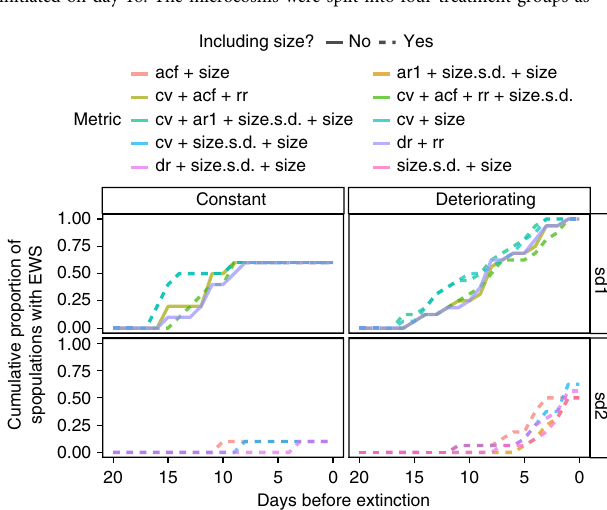
Figure 4 | Timing of early warning signals when including or excluding information on trait dynamics. The cumulative proportion of populations in the constant or deteriorating treatments that showed early warning signals with a threshold of either 1 or 2 s . The metrics displayed are the five metrics with the highest normalized metric score at 1 or 2 s in the constant treatment and across all three of the deteriorating treatments (slow, medium and fast). acf, autocorrelation; ar1, autoregressive coefficient; cv, coefficient of variation; dr, density ration; rr, return rate; size, mean body size; size.s.d., s.d. of body size.